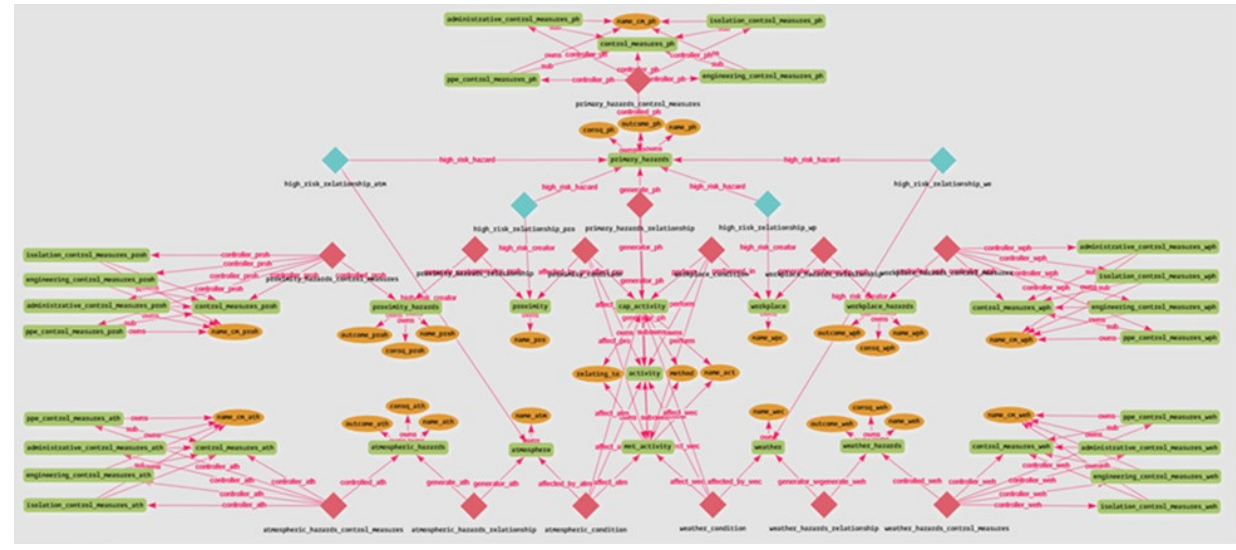
Figure 9. Visualization of O-JHAKG implemented in Grakn.